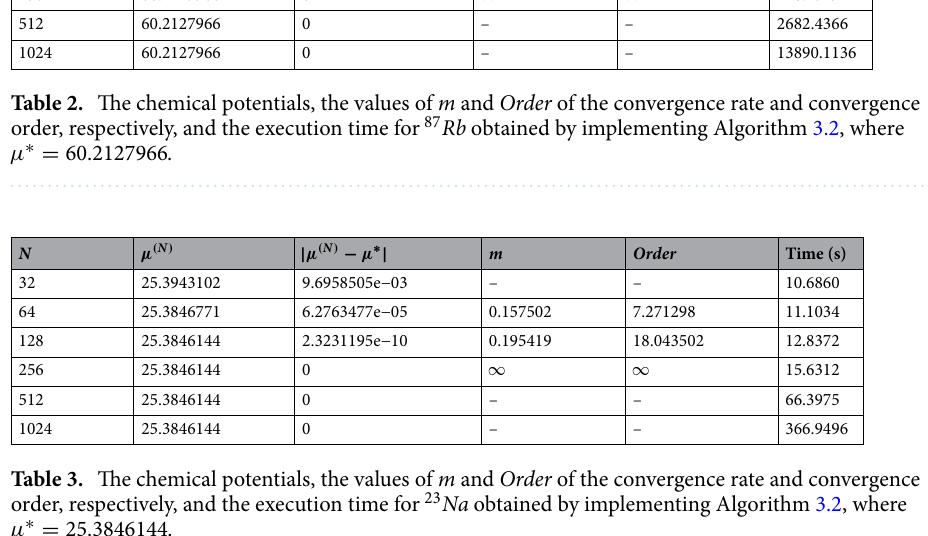
23 Na obtained by implementing Algorithm 3.2, where